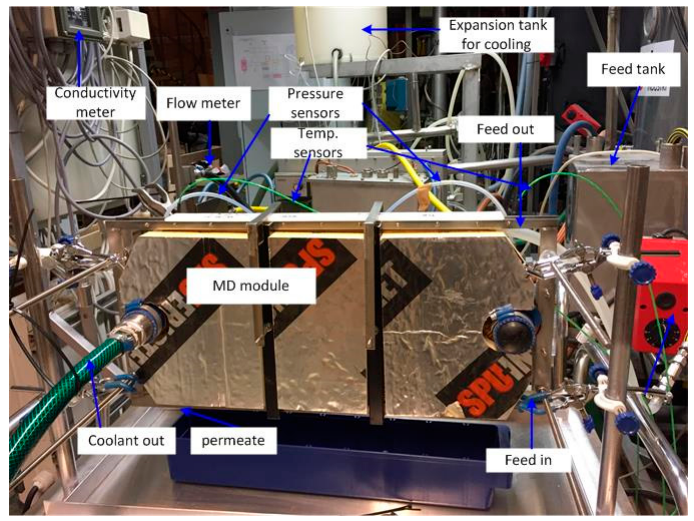
Figure 3. Bench scale Elixir500 AGMD test unit at KTH Royal Institute of Technology, Energy Department laboratory.